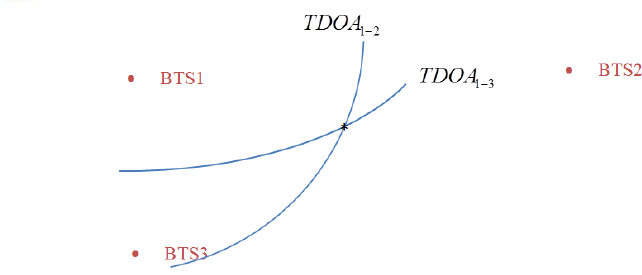
Figure 4. Angle of arrival positioning method